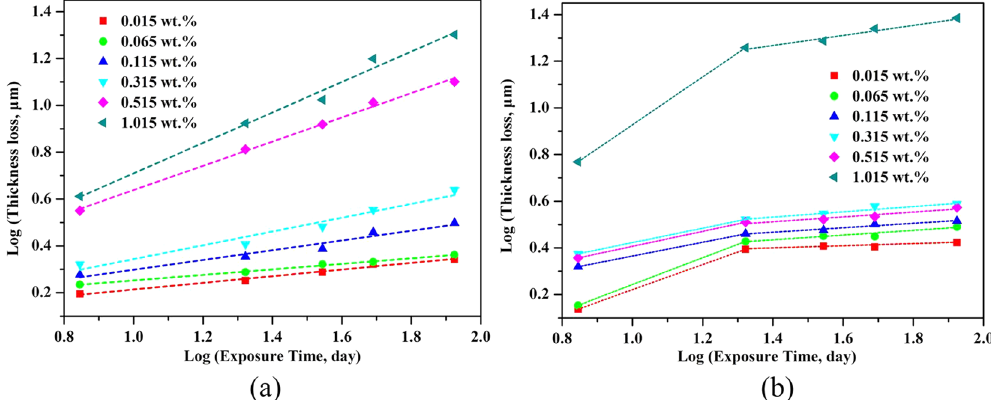
Figure 7. Bilogarithmic plots of thickness loss versus exposure time of ductile iron ( a ) and carbon steel ( b ) after being exposed in soils with different levels of